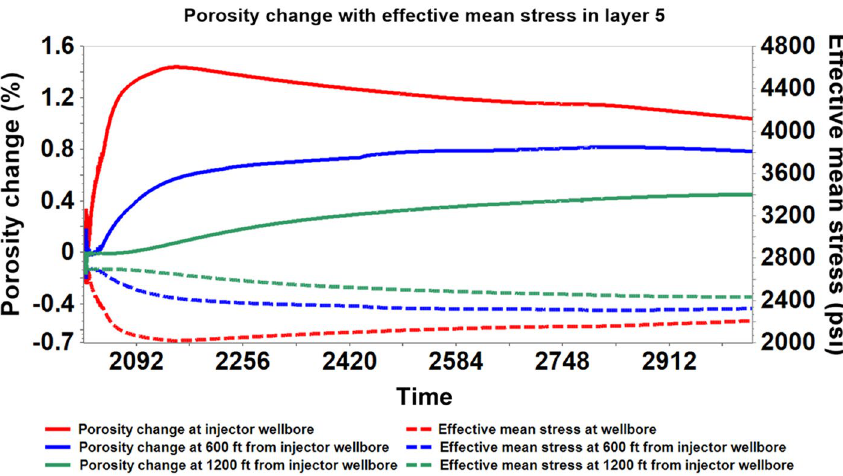
Figure 13. The evolution of stress-induced porosity changes with effective mean stress within the bottom caprock layer (Layer 5) at variable distances from the wellbore during 1000 years of post-injection monitoring.